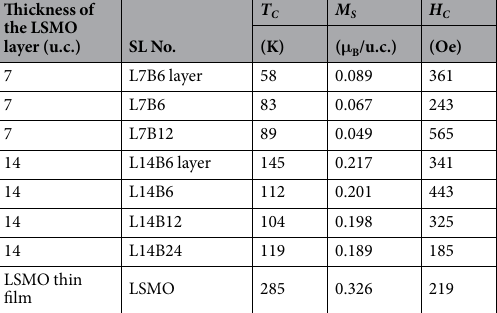
Thickness of the LSMO layer (u.c.)